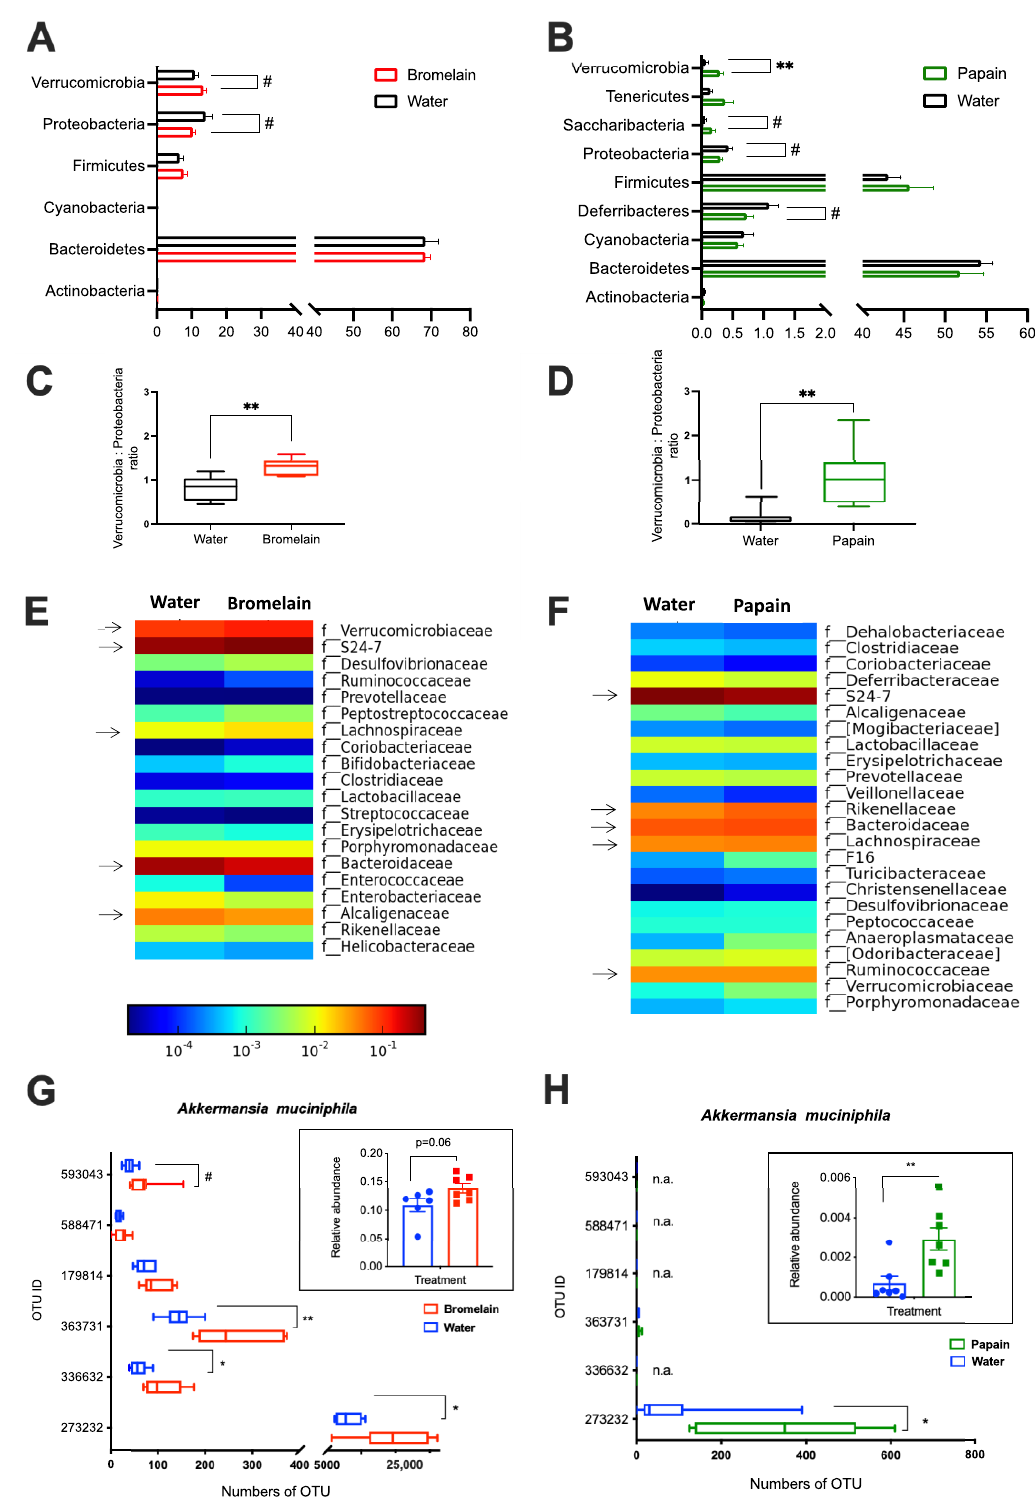
Figure 3. Composition of the gut microbiota in mice from Bromelain ( A , C , E , G ) and Papain experiments ( B , D , F , H ). Bar plots show the relative abundance of cecal bacterial community at Phylum level ( A , B ); the ratio between Verrucomicrobia to Proteobacteria ( C , D ); Family level ( E , F ) and amount of OTU ID in each experimental group which has been assigned to Akkermansia muciniphila ( G , H ). Data are shown as mean ± SEM, (n = 6–7 per group) * p < 0.05, ** p < 0.01, # p < 0.1. Arrows indicate the five most abundant families.